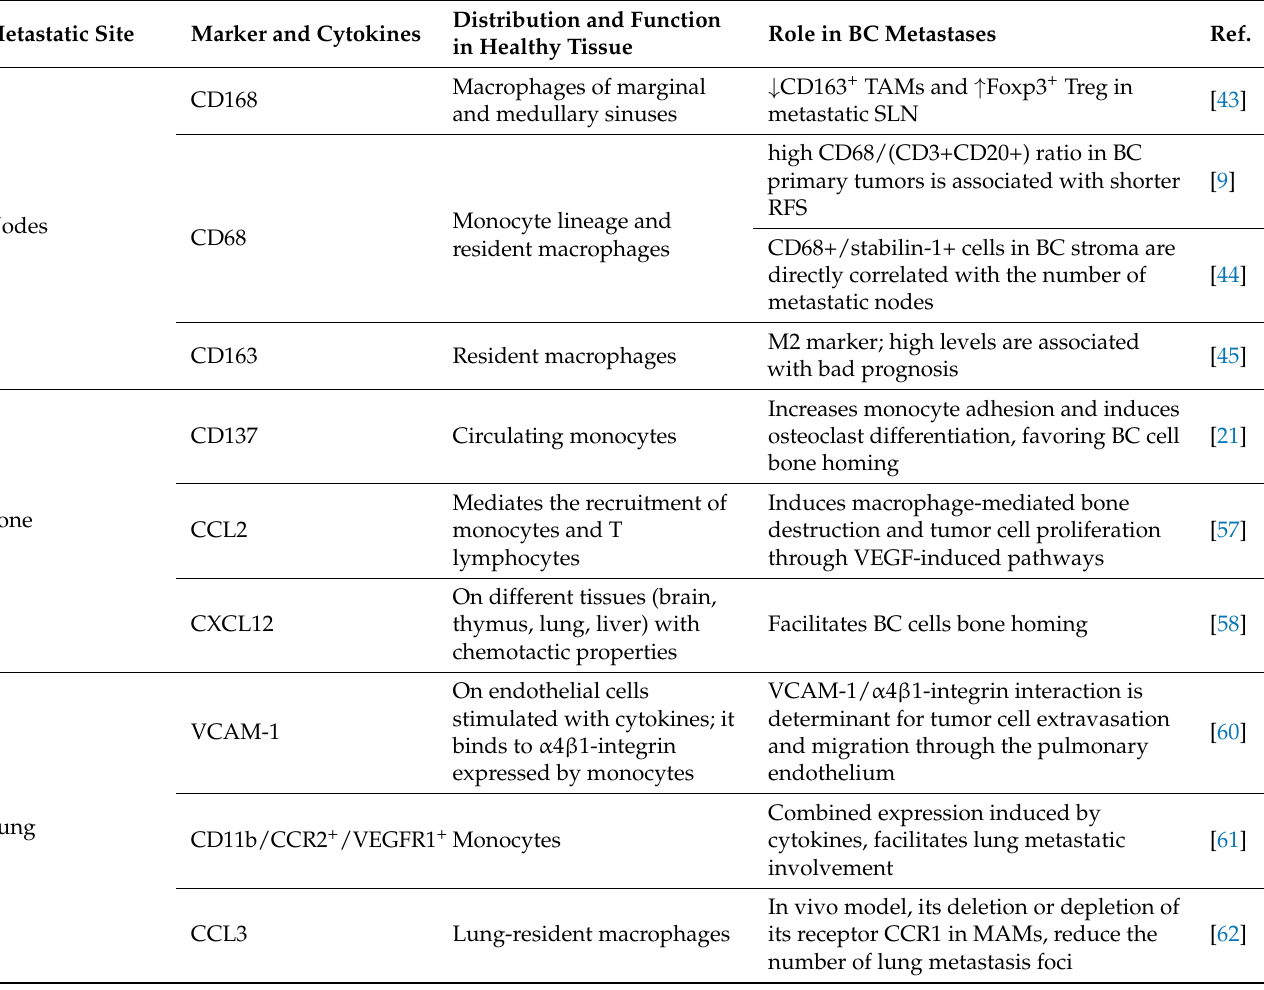
Table 1. Role of tumor-associated macrophages (TAMs) at different breast cancer (BC) metastatic